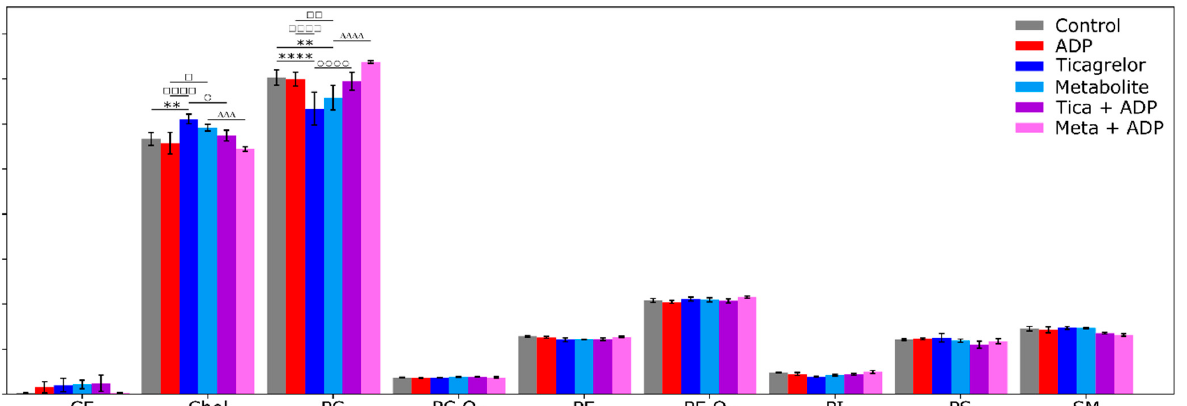
Figure 3. Fatty acid species in the plasma membrane of resting platelets represented by chain length and number of double bonds. The area of each circle is proportional to the abundance of each fatty acid in mol%. acid in mol%.